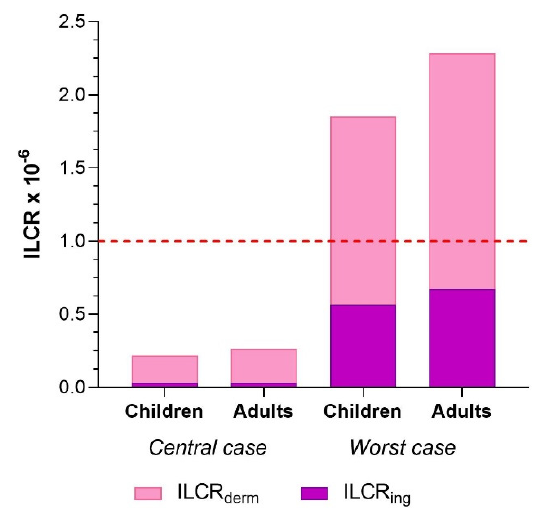
Figure 3. Incremental lifetime cancer risk (ILCRs) for children and adults from PAHs in household dust samples from the city of Zagreb.